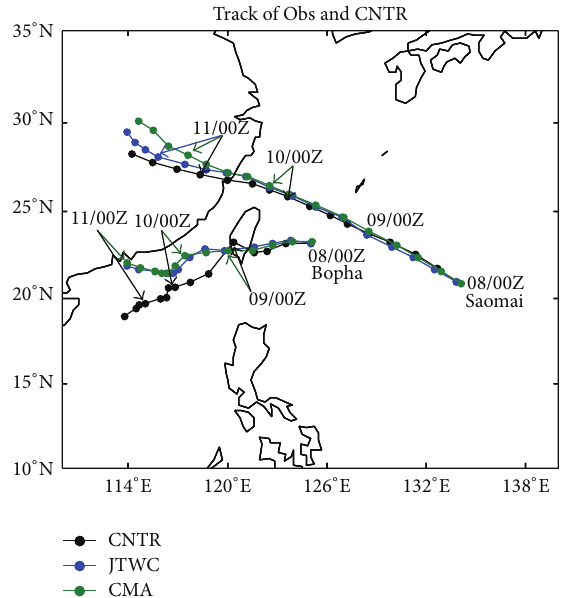
Figure 2: Best tracks of CMA and JTWC and simulated tracks of Bopha (2006, 09W) and Saomai (2006, 08W) from 0000 UTC 8 August to 1800 UTC 11 August,